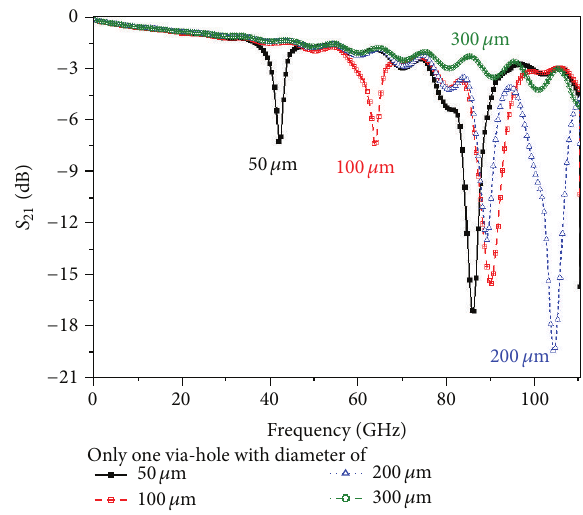
Figure 5: Transmission coefficient 𝑆 21 (dB) of the back-to-back transitions with only one via-hole (located 500 𝜇 m from both axes I and II; cf. Figure 3) for different diameters (50 𝜇 m, 100 𝜇 m, 200 𝜇 m, and 300 𝜇